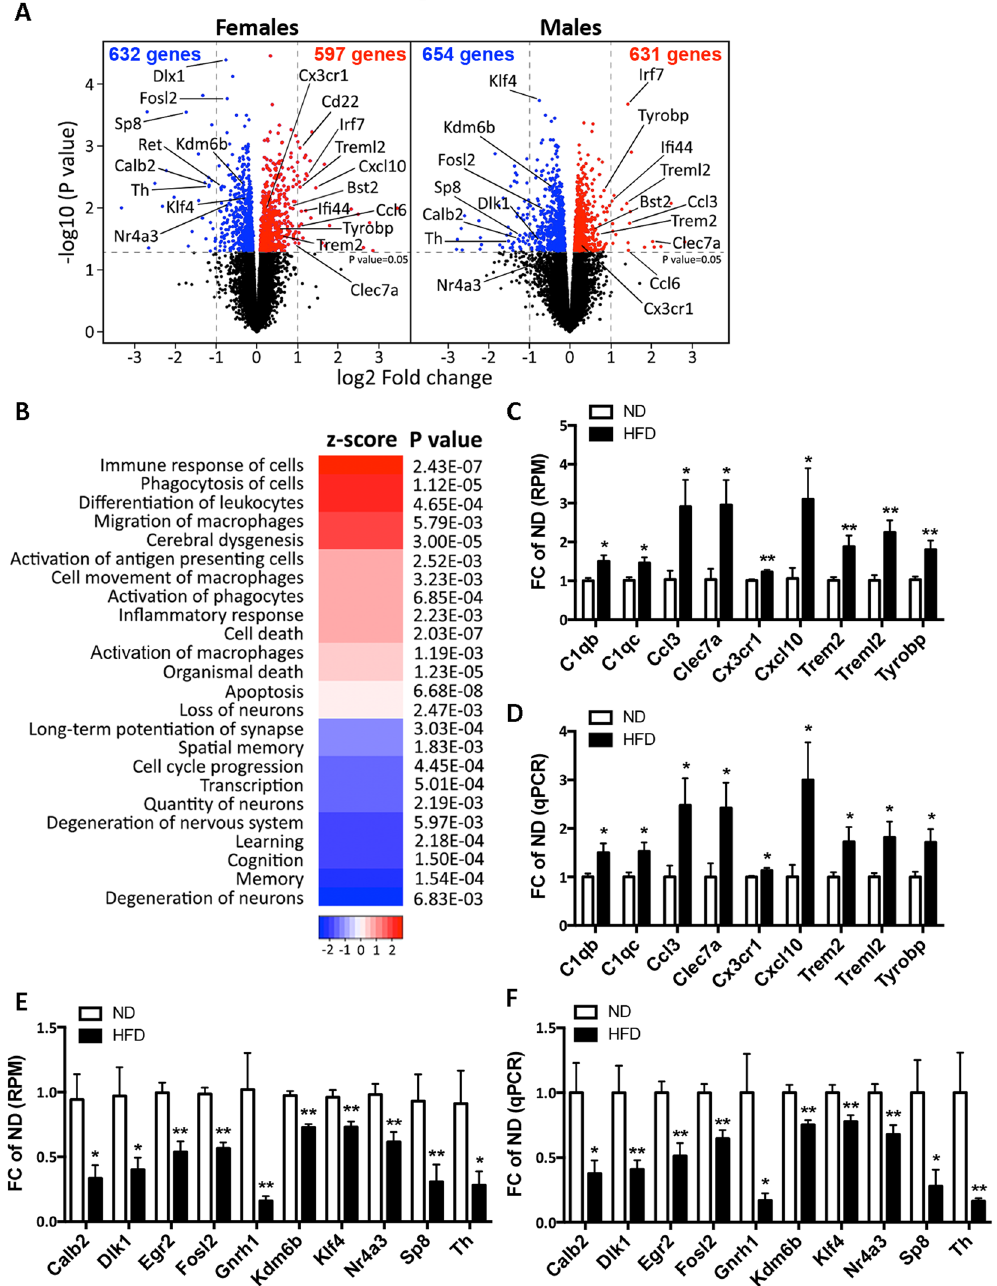
Figure 2. HFD affects the expression of genes associated with immune response and neuron differentiation. RNA-seq was performed on RNA isolated from cortices of APP23 mice shown on Fig. 1. ND, N = 4–6/gender; HFD, N = 5/gender. ( A ) Volcano plot representing the RNA-seq results. Red indicates up-regulated genes by HFD; blue down-regulated genes at a cutoff p < 0.05. ( B ) Heatmap representing the z-score of diseases/function annotations significantly affected by HFD (calculations by IPA). Positive z-score (red) indicates a predicted up- regulated function and negative z-score (blue) is a down-regulated function. ( C and D ) Significantly changed genes associated with “Immune response” and “Inflammation” in RNA-seq datasets ( C ) and qPCR validation ( D ). ( E and F ) Genes related to “Neuron Differentiation” and “Regulation of transcription” in RNA-seq ( E ) and qPCR validation assays ( F ). Fold change (FC) of ND was calculated from the number of reads per million (RPM) for each gene and each sample. For C and E, statistics is by edgeR. For D and F, statistics is by t -test, * p < 0.05; ** p < 0.01. N =